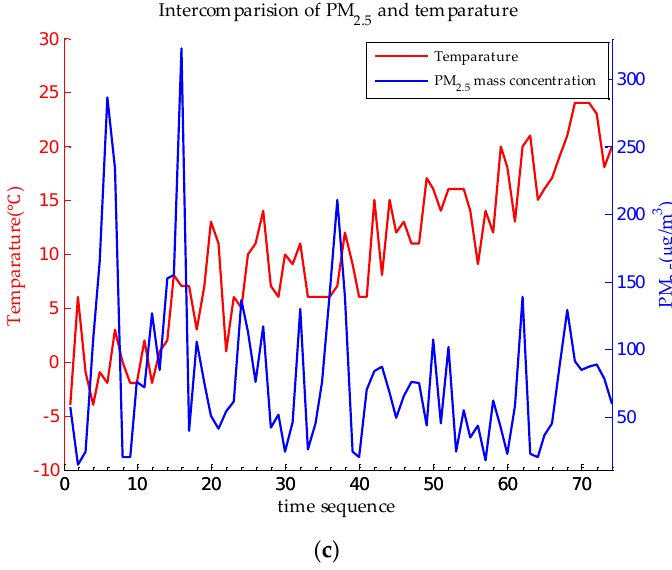
Figure 4. Time sequence diagram of various nighttime meteorological elements and PM 2.5 concentration monitoring value in Beijing in Spring. ( a ) Time sequence diagram of relative humidity and PM 2.5 concentration monitoring value; ( b ) Time sequence diagram of wind speed and PM 2.5 concentration monitoring value; ( c ) Time sequence diagram of temperature and PM 2.5 concentration monitoring value.